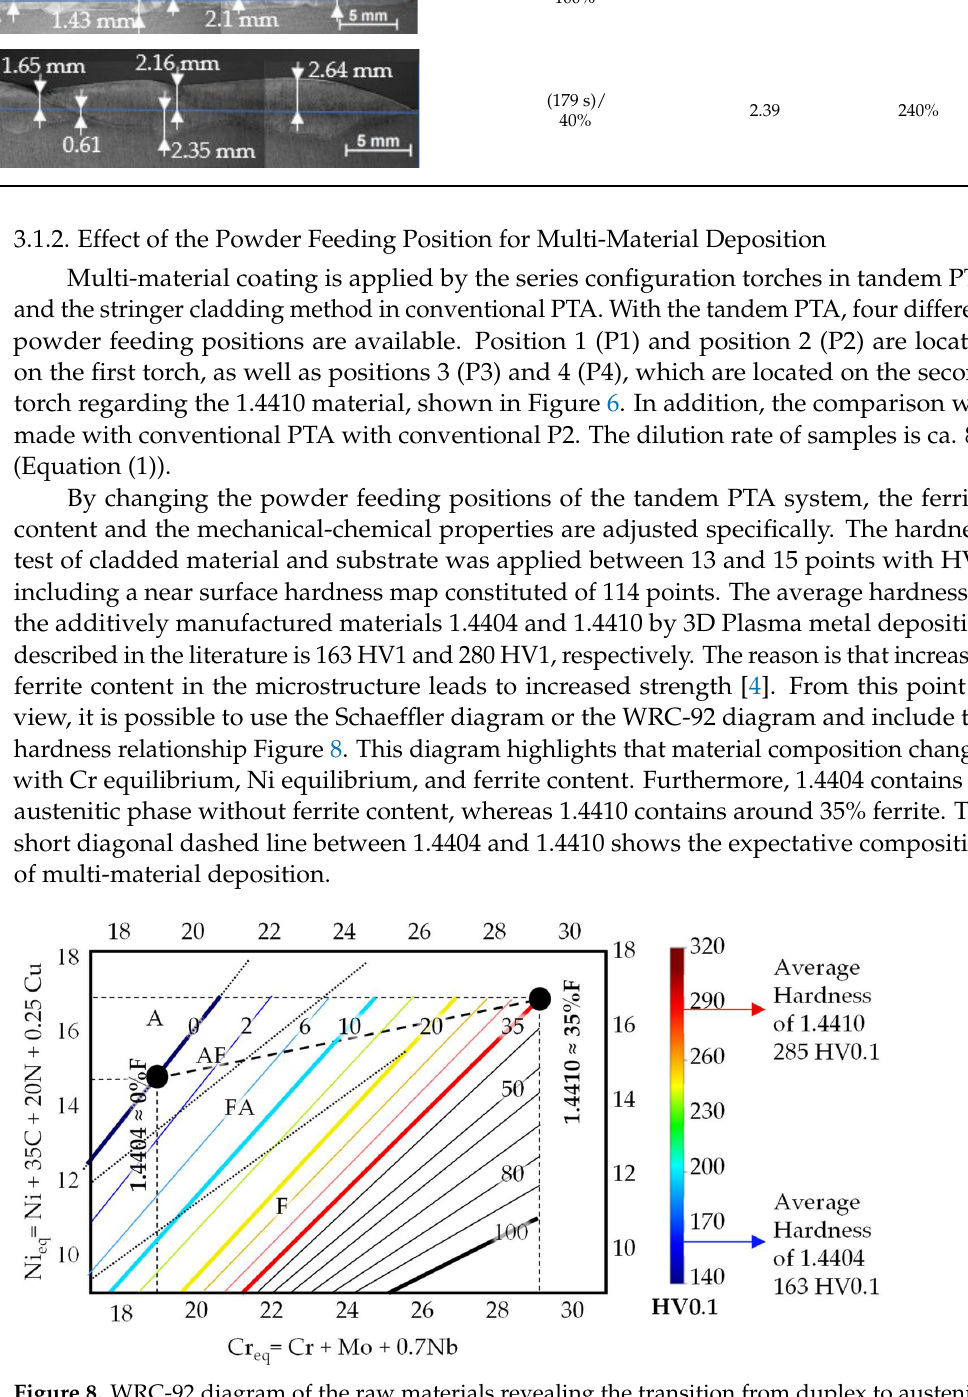
Figure 8. WRC-92 diagram of the raw materials revealing the transition from duplex to austenitic structure (A = austenite, AF = austenite + ferrite, FA = ferrite + austenite, F = ferrite) based on [25] and [4] with hardness scale used for the following hardness measurements.